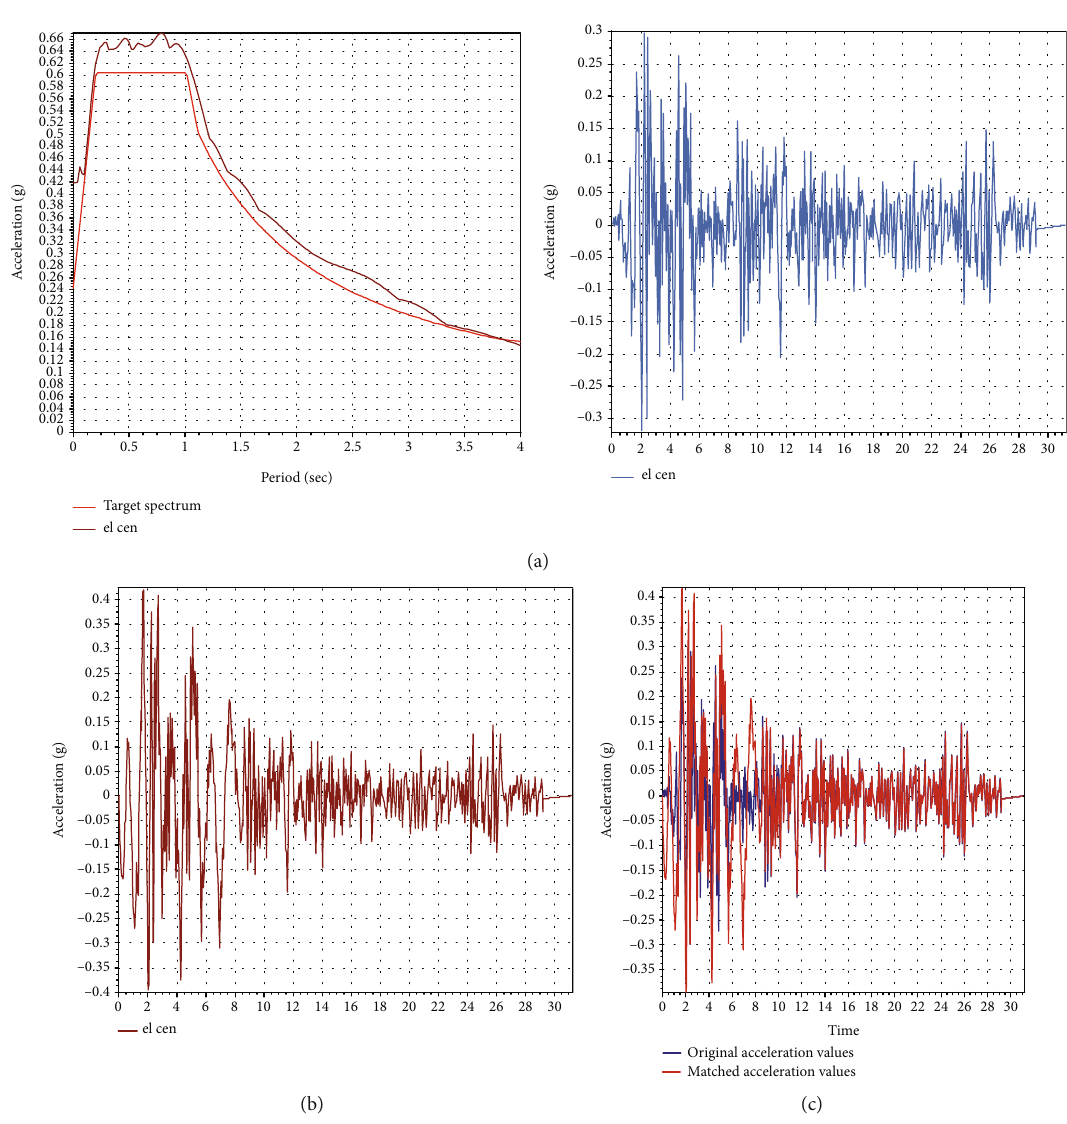
Figure 4: (a) Matched accelerogram El-Centro 1940 with spectrum response of Denpasar, (b) original acceleration time history of El-Centro 1940 N-S , and (c) matched acceleration time